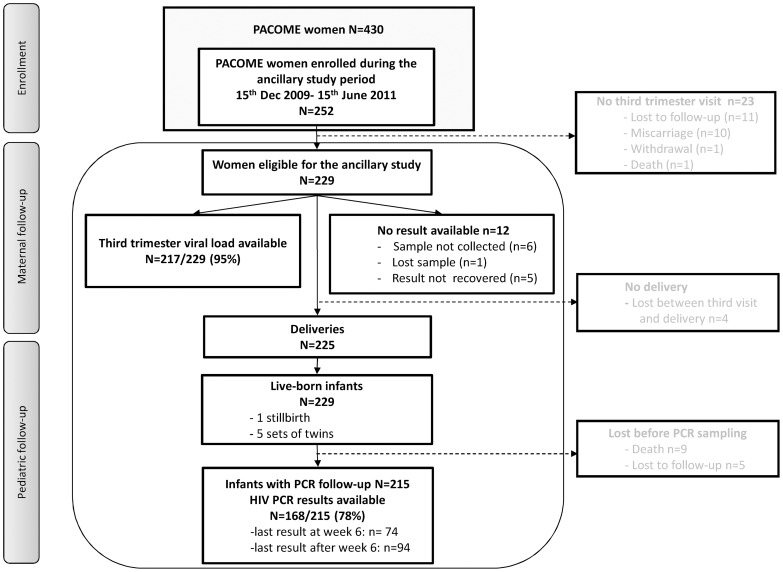
Study flow-chart.Women were eligible for the ancillary study if they had been enrolled during the study period and had their third trimester visit performed.